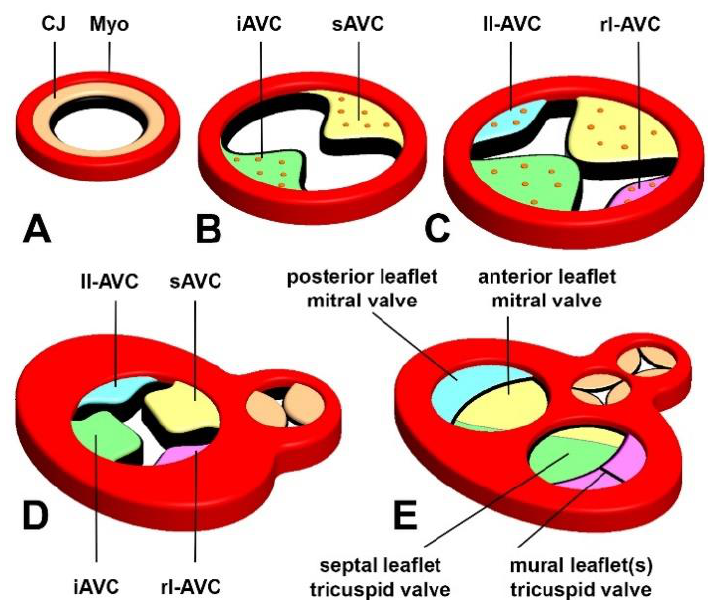
Figure 1. Origin and Fate of the AV cushions. This illustration reflects the respective stages of AV cushion formation. ( A ) Cardiac jelly accumulates between myocardium and endocardium in the tubular heart, ( B ) formation of the major AV cushions, ( C ) fusion of the major cushions and formation of the lateral cushions. ( D , E ) illustrate how the respective cushion contribute to the leaflets of the formed heart. CJ, cardiac jelly; Myo, myocardium; iAVC, inferior AV cushion; sAVC, superior AV cushion; ll-AVC, left lateral AV cushion; rlAVC, right lateral AV cushion, muMiV, mural leaflet of the mitral valve.